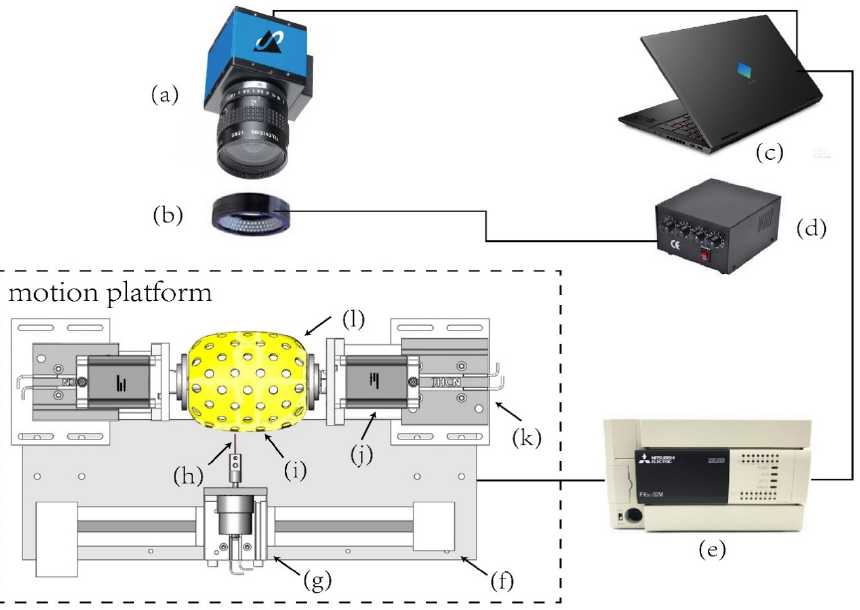
Figure 1. Structure of the test platform. ( a ) color camera, ( b ) ring light source, ( c ) notebook, ( d ) light source controller, ( e ) PLC controller, ( f ) linear slide, ( g ) probe cylinder, ( h ) probe, ( i ) pineapple eye, ( j ) servo motor, ( k ) clamping cylinder, and ( l ) pineapple.